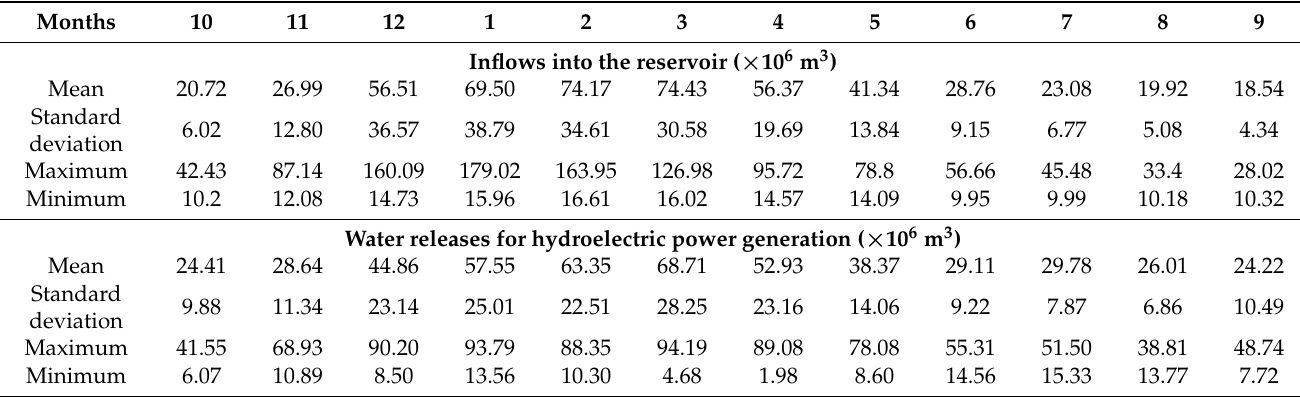
Table A1. Statistical characteristics of time series of measured mean monthly inflows into Ladhon Reservoir (1956–2012) and water releases (1960–1971 and